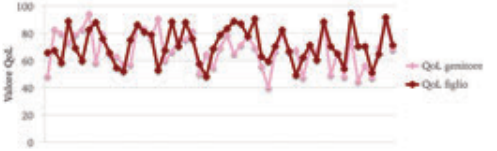
Figura 1. Risultati Questionario PedsQoL 3.0 - Confronto tra i valori ottenuti dai genitori e dai figli.